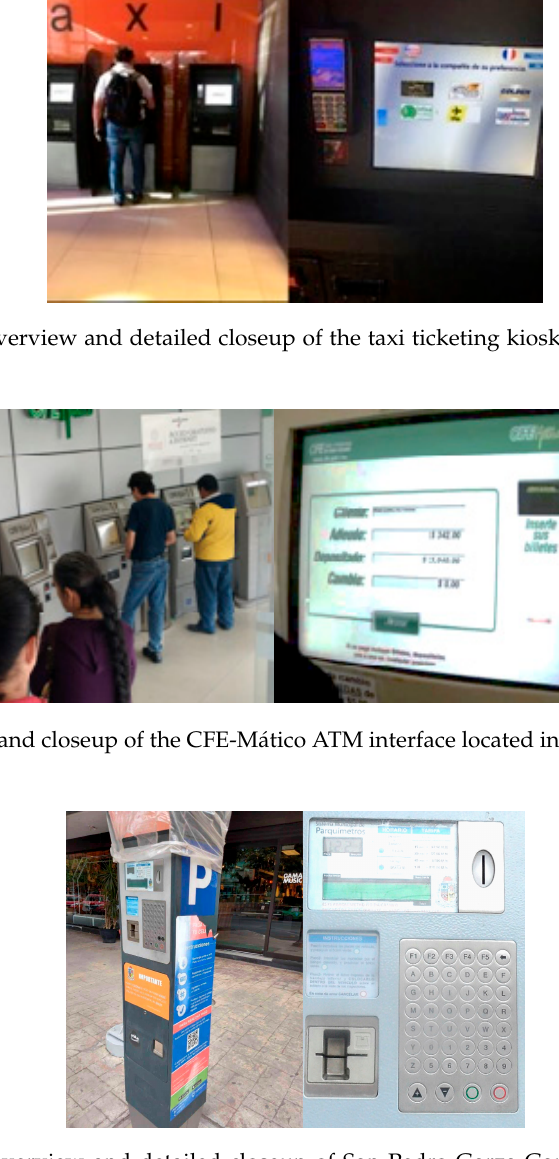
Figure 5. General overview and detailed closeup of San Pedro Garza García Town Hall parking meter, Mexico.